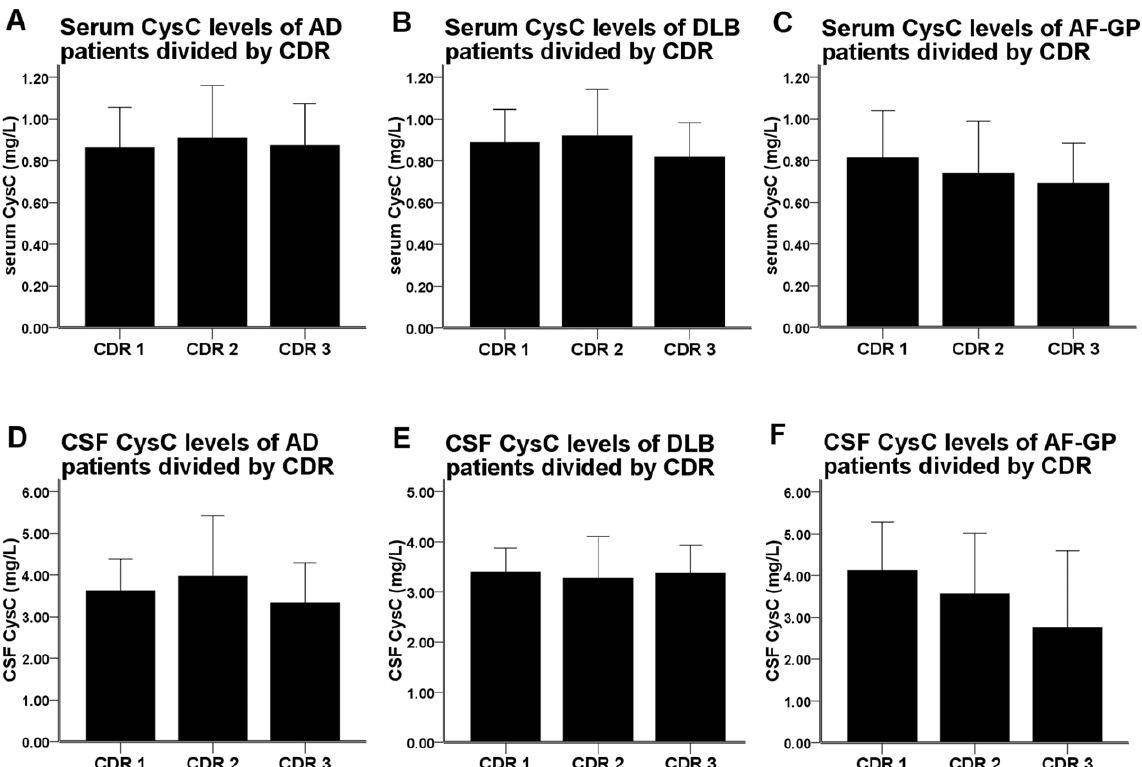
Figure 4. The serum and CSF CysC levels of dementia patients divided by CDR scores. No significant differences in serum or CSF CysC levels were observed in patients with AD (A and D), DLB (B and E) and AF-GP (C and F). Statistically significant difference was calculated using one- way ANOVA. Data are means 6 SD. Abbreviations: CysC, cystatin C; CDR, Clinical Dementia Rating Scale; AD, Alzheimer’s disease; DLB, dementia with Lewy body; AF-GP, the atrophic form of general paresis.